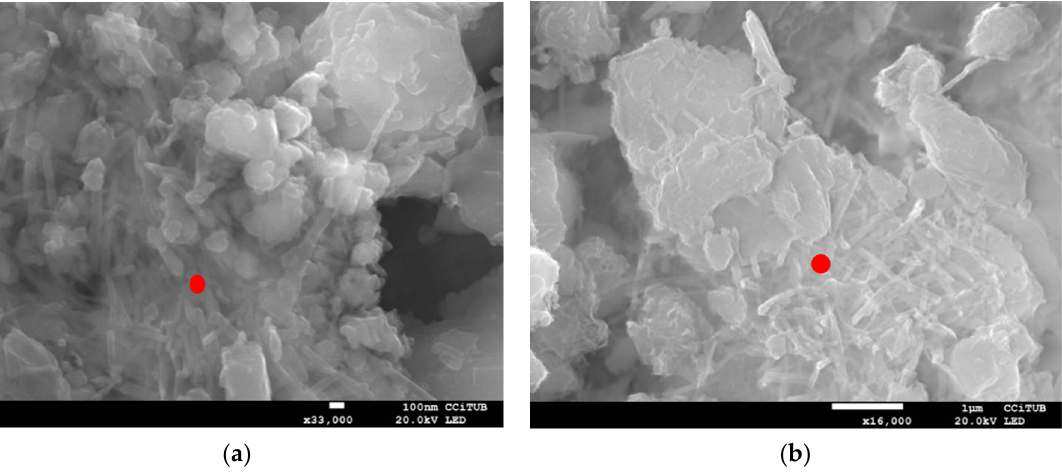
Figure 22. SEM images of soils treated with WPFA ( a ) and cement ( b ) at 360 days. Red dots indicate the formation of